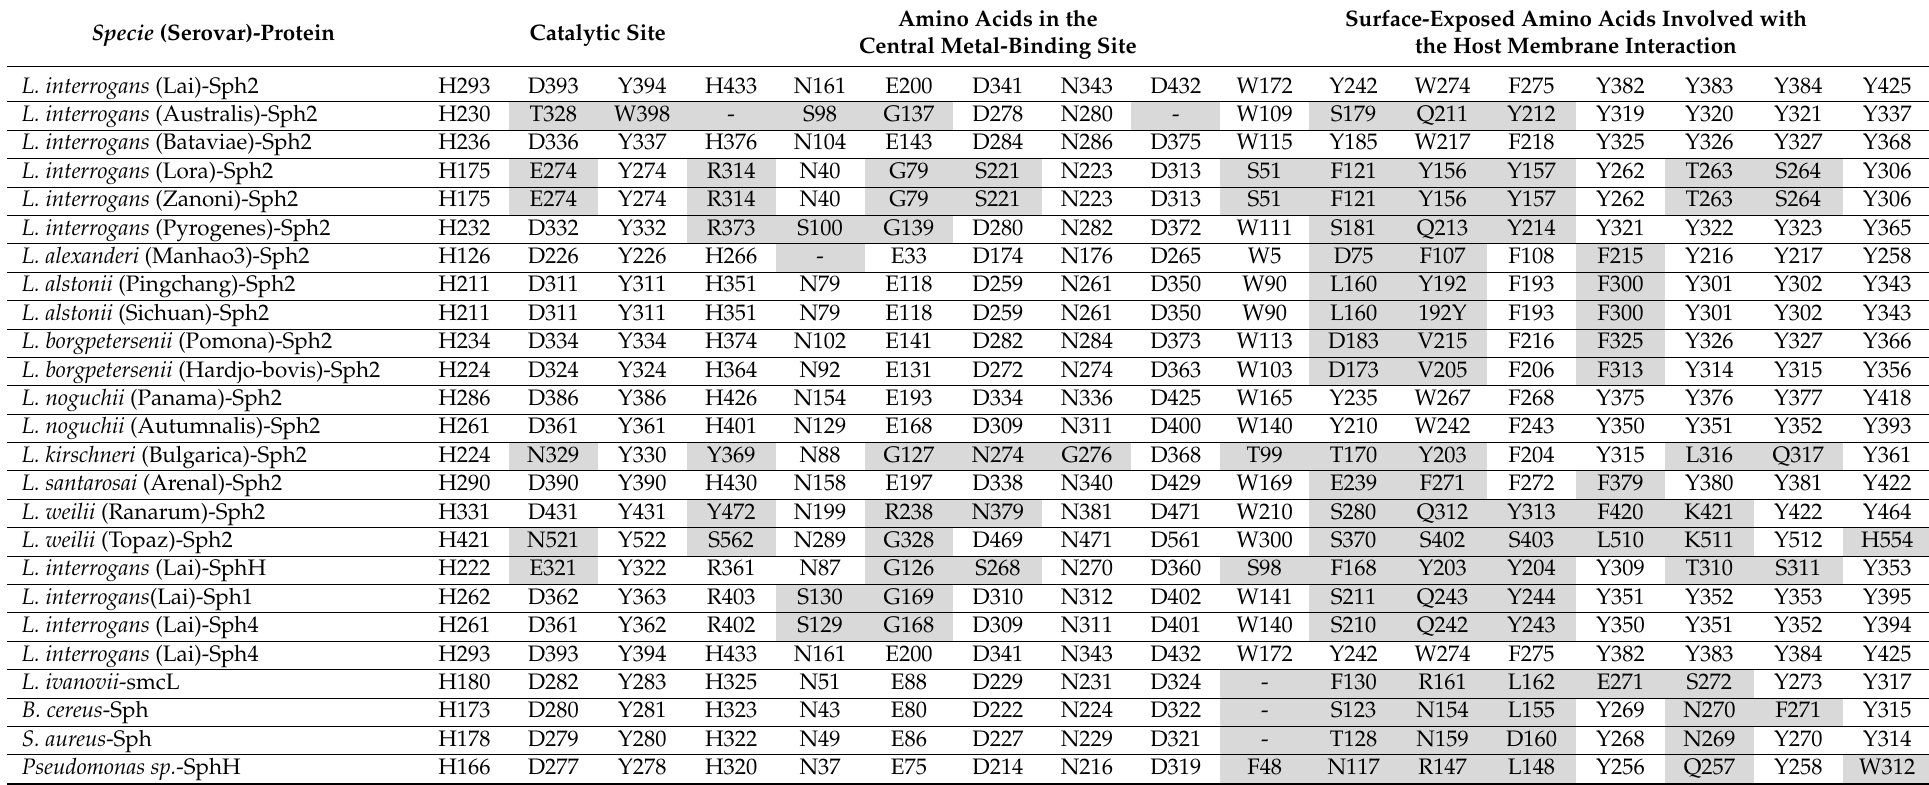
Table 4. Amino acids in pathogenic leptospires Sph2 catalytic sites, metal-binding sites, and amino acids involved in host membrane